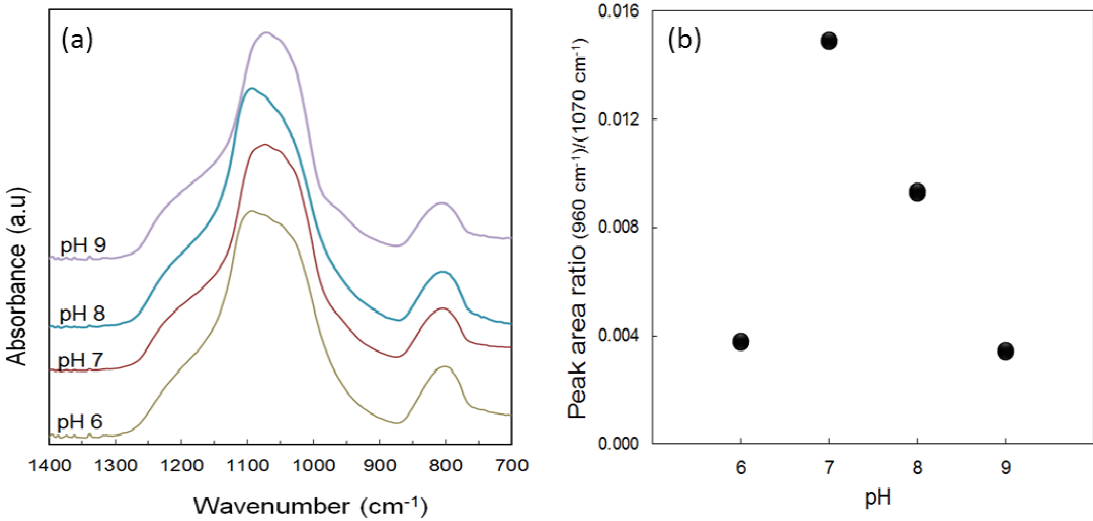
Figure 2. ( a ) FTIR spectra of the calcined silica xerogels and ( b ) the peak area ratio of the silanol peak at 960 cm − 1 against the siloxane peak at 1070 cm − 1 for the spectra as a function of the sol